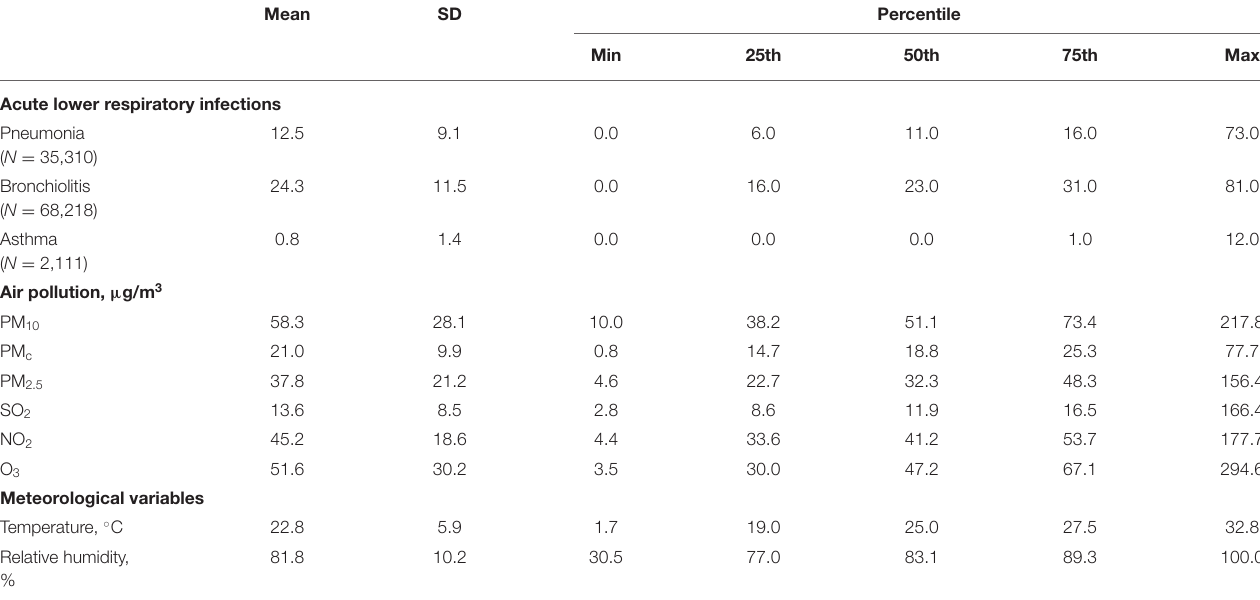
TABLE 1 | Summary statistics of acute lower respiratory infections outpatient visits, air pollutants, and meteorological variables.